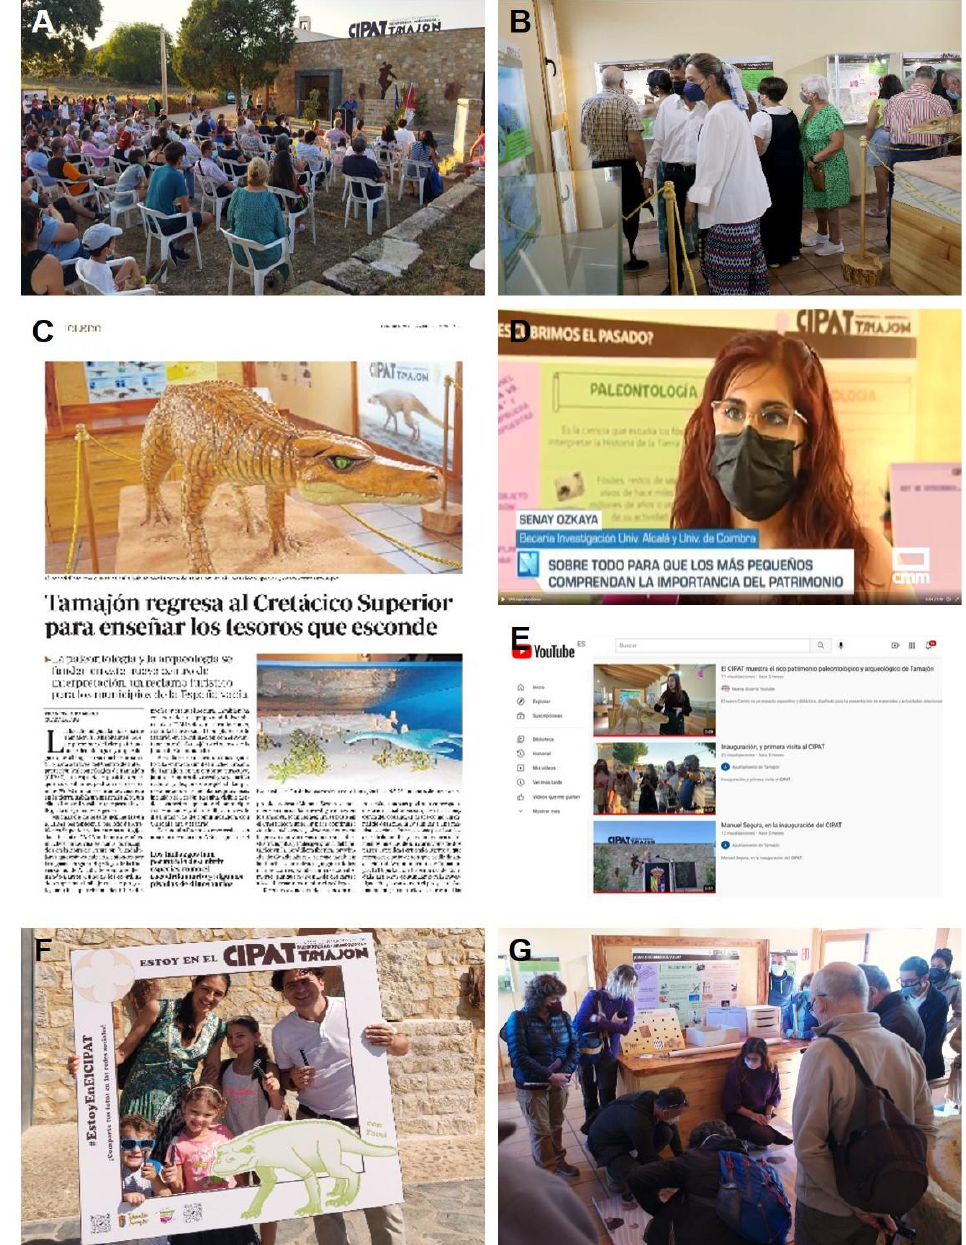
Figure 8. ( A , B ) Inauguration of the Paleontological and Archaeological Interpretation Centre of Tamajón (CIPAT) (20 August 2021); ( C – E ) Different media covering the inauguration and first days of the CIPAT: ABC Newspaper ( C ); Castilla-La Mancha Television ( D ); and Youtube Website ( E ); ( F , G ) A family visit, in the outer facade ( F ); and the development of an educational activity, in the Didactic Area of the CIPAT ( G ).